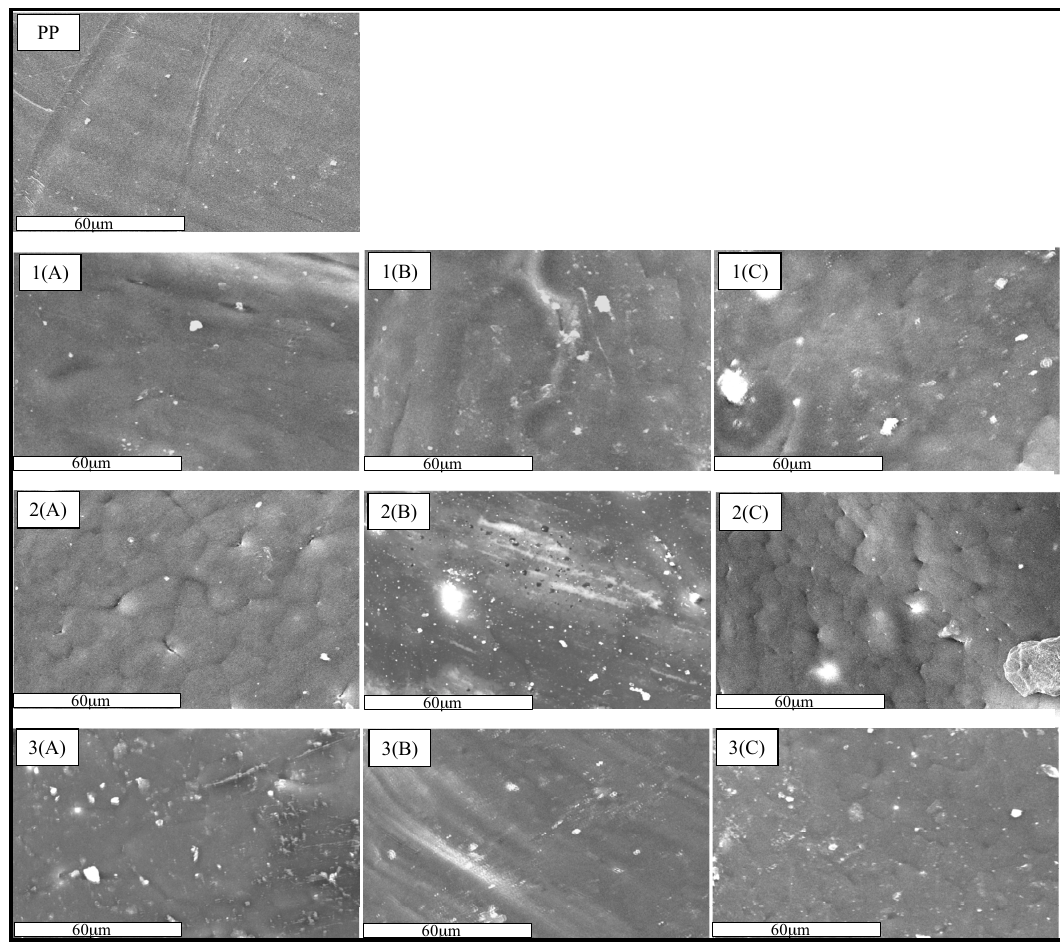
Figure 3. SEM Images: ( A – C ) films with 5%, 7%, and 9% of chitosan content, respectively; (1) films without compatibilizer; (2) films with compatibilizer; (3) films with milled chitosan and compatibilizer. 1000× magnification.